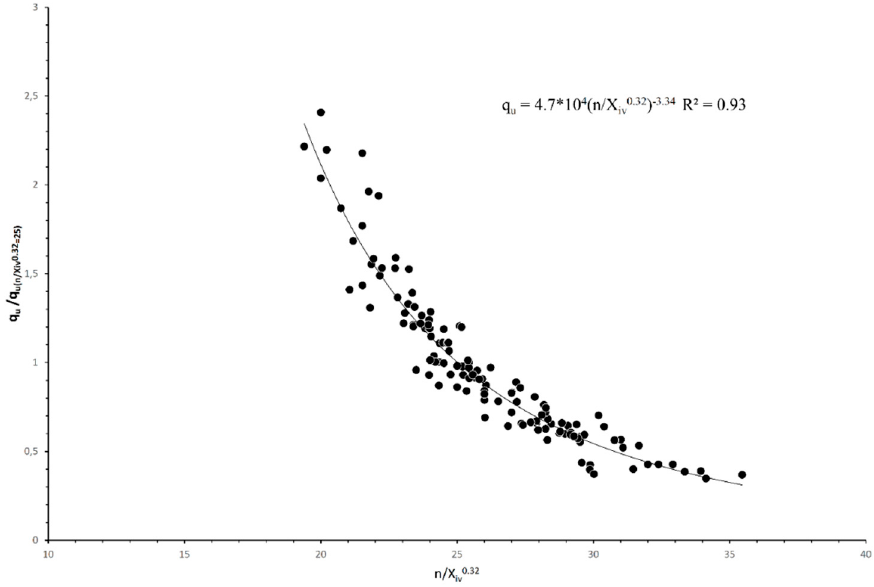
Figure 7. Normalization of unconfined compressive strength (q u ), (for the whole range of η / X iv0.32 ) by dividing for q u at η / X iv0.32 = 25. Considering all studied blends.